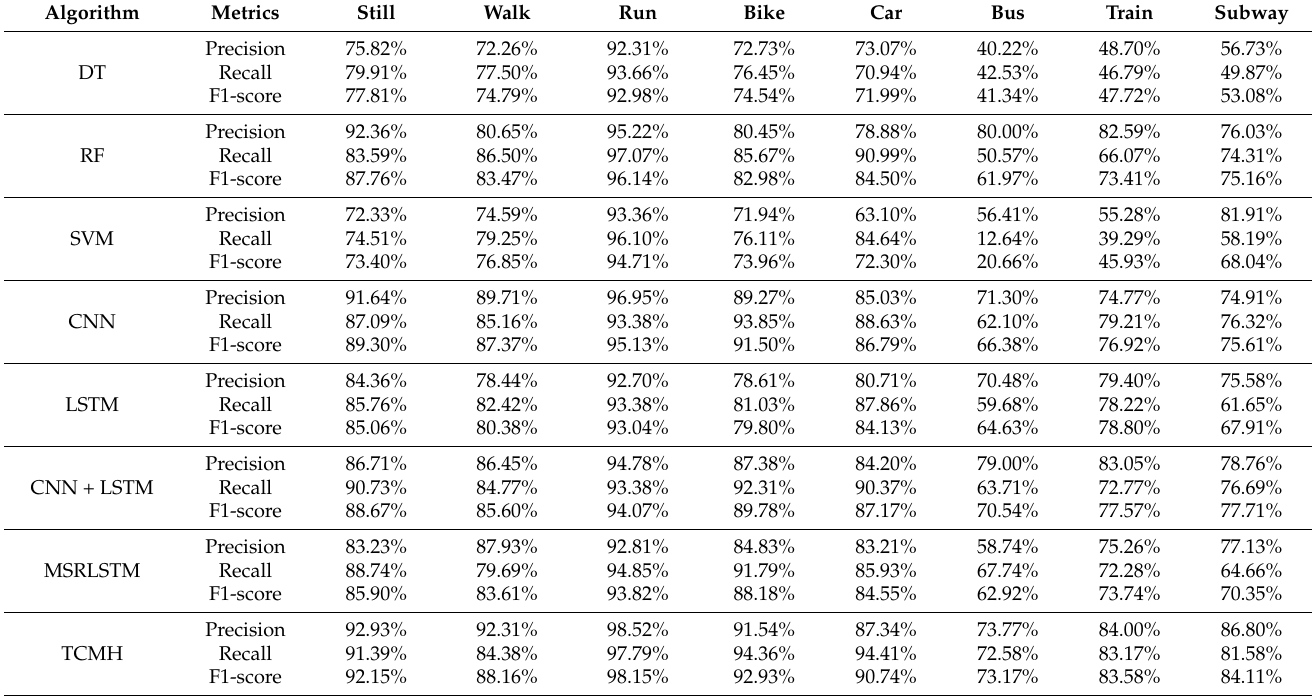
Table 4. Comparison of evaluation metrics of different algorithms on the HTC